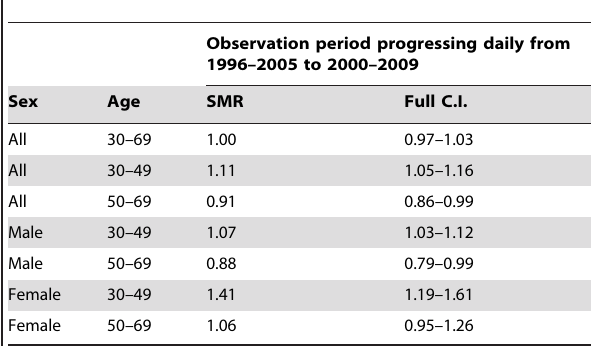
Table 5. Proposed 10-year observation period, with four years of daily re-sampling.